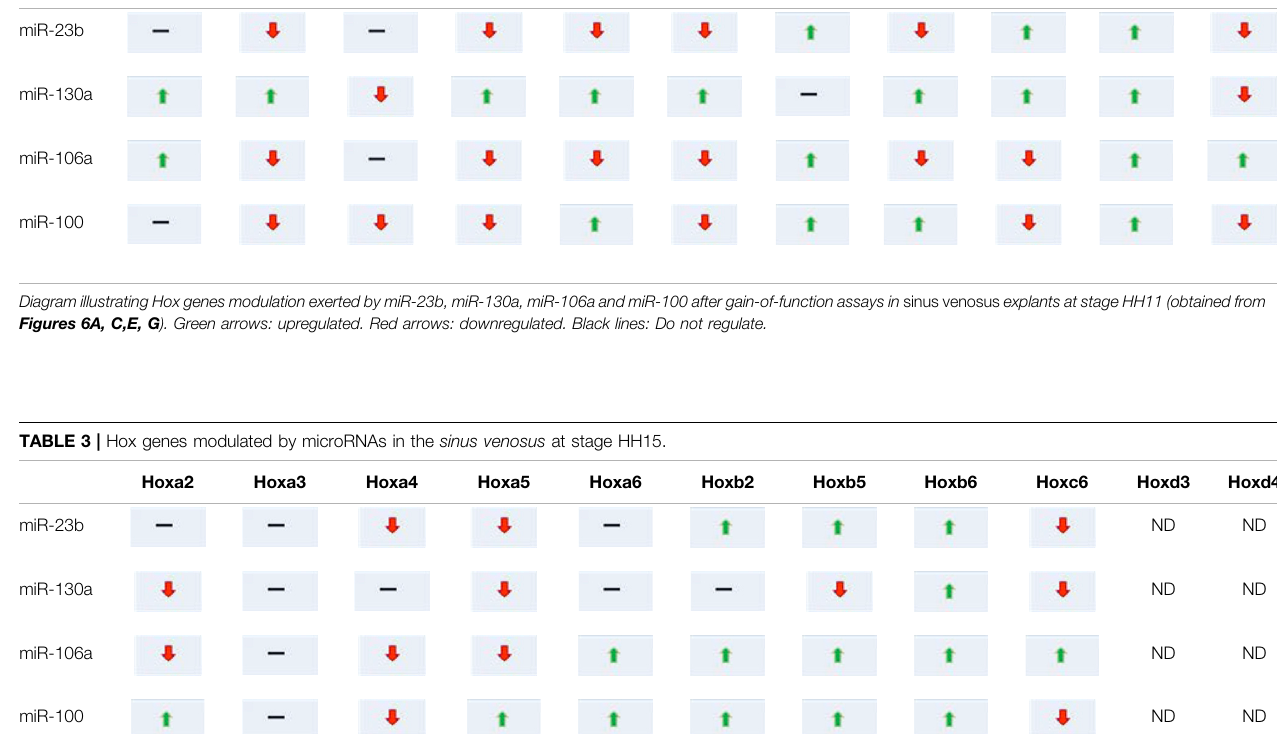
TABLE 2 | Hox genes modulated by microRNAs in the sinus venosus at stage HH11. Hoxa2 Hoxa3 Hoxa4